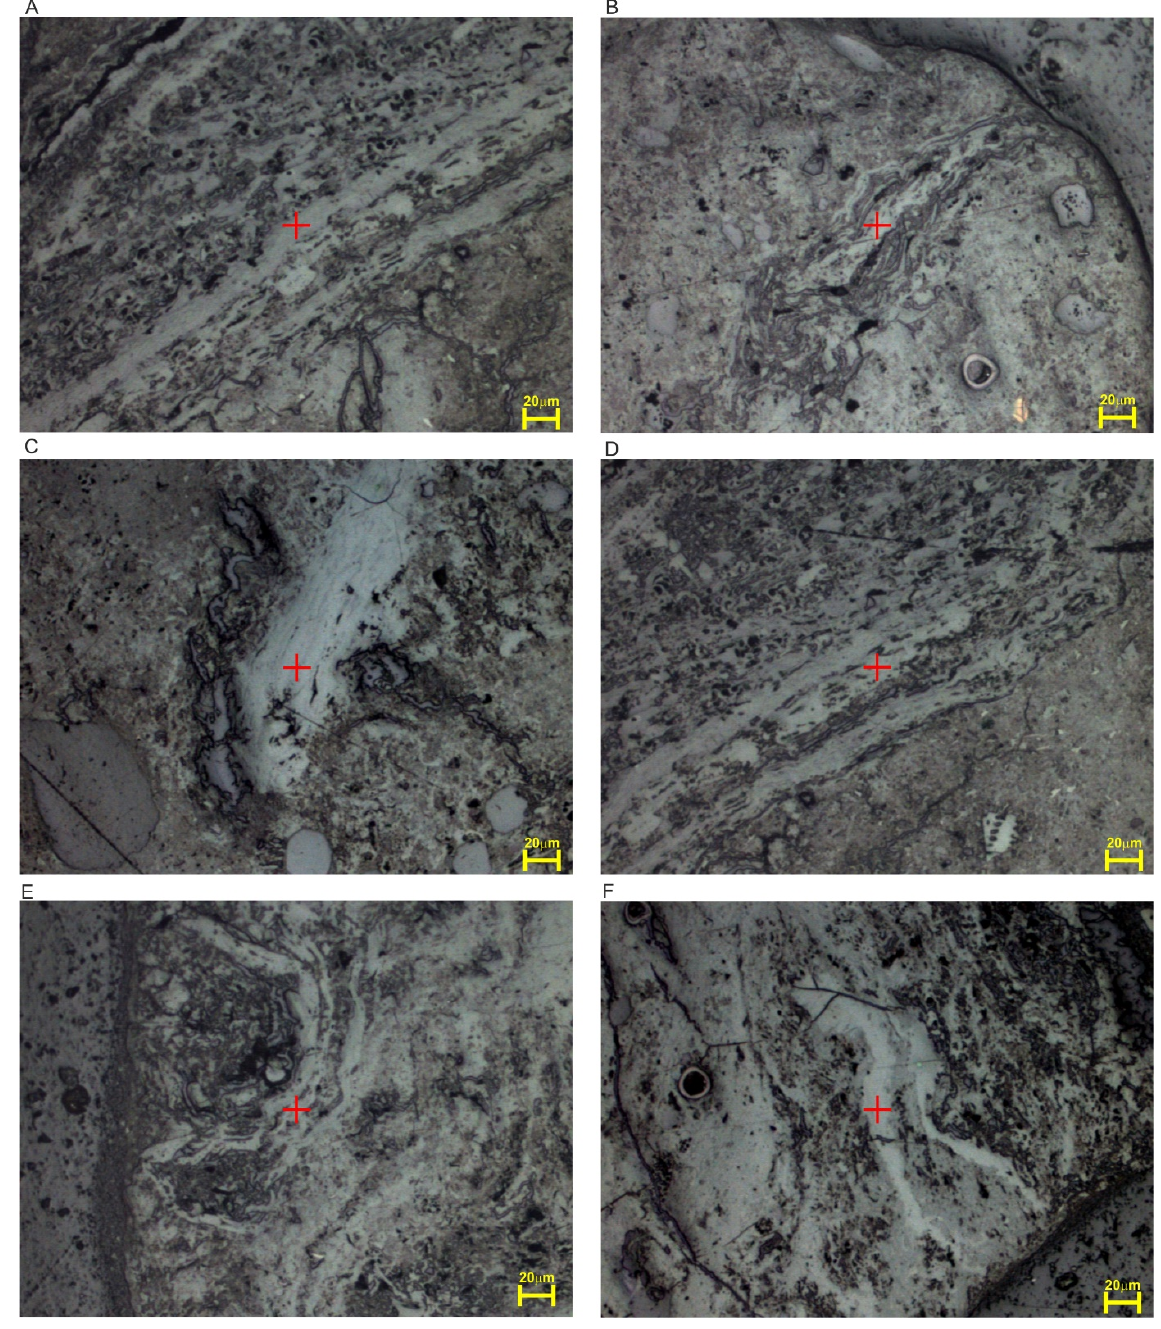
Figure A3. Selected measurement points (+) on ulminite ( A – F ).